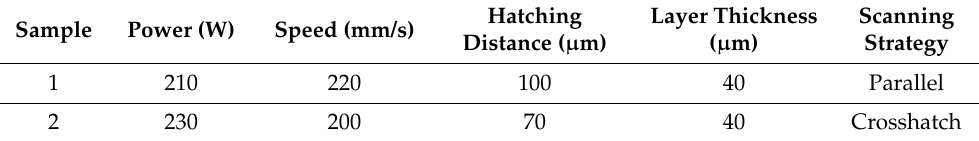
Hatching Layer Thickness Scanning Distance ( µ m) ( µ m) Strategy